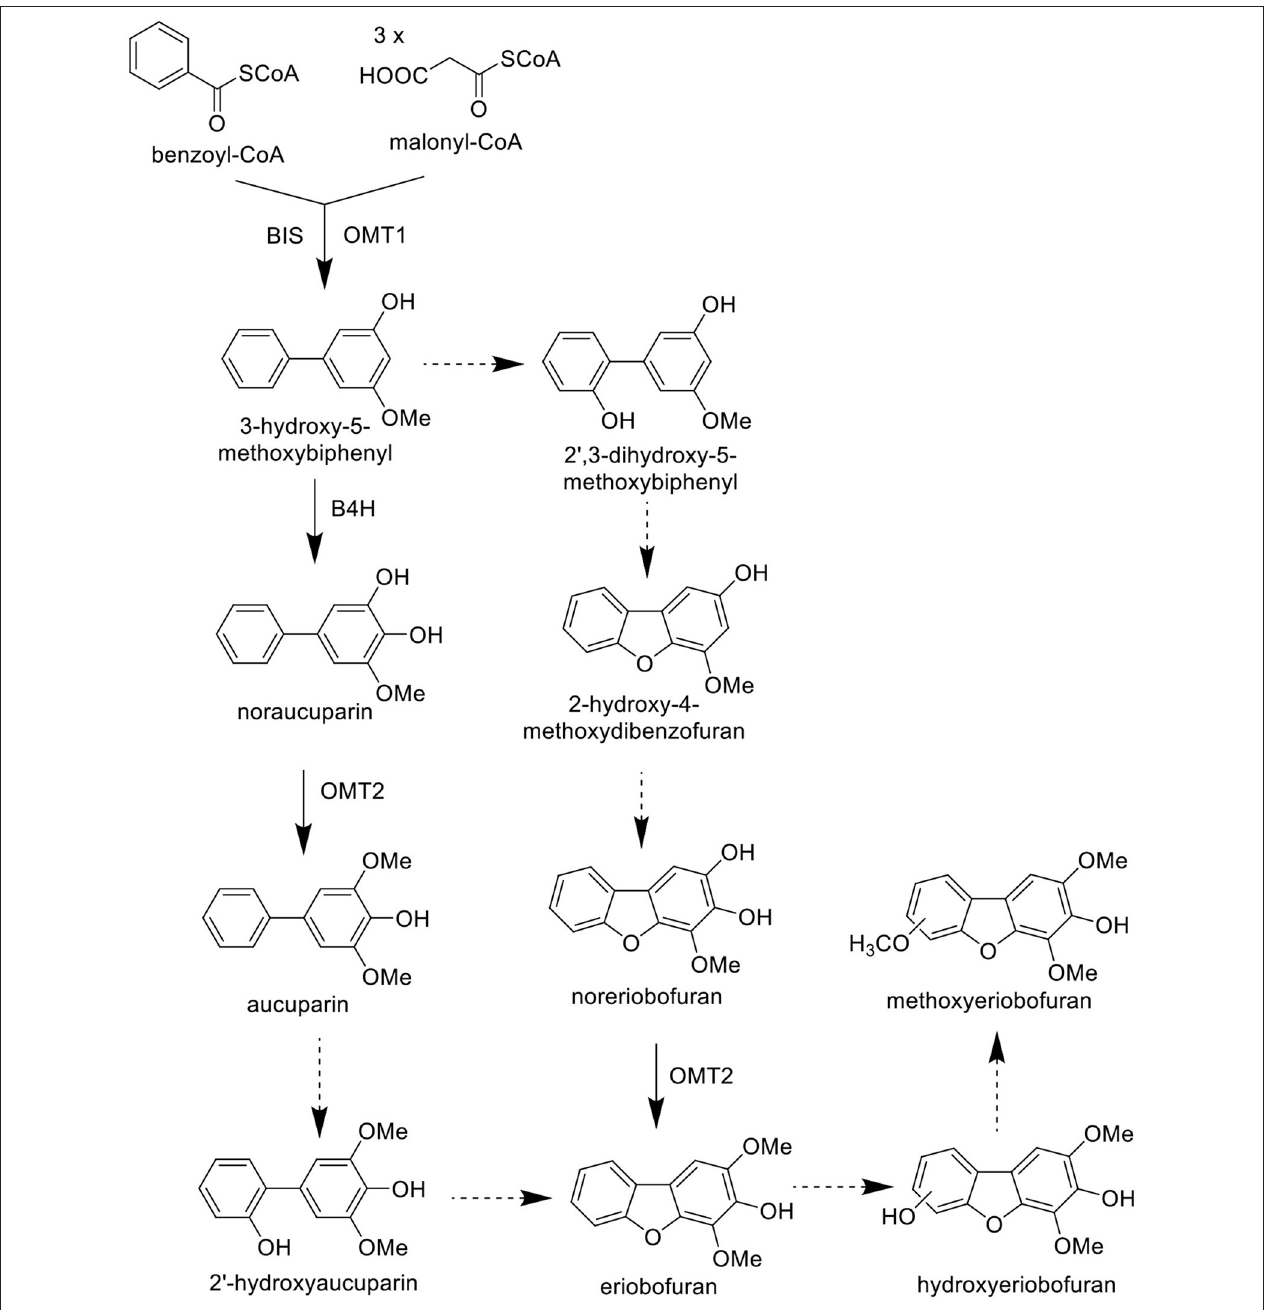
FIGURE S2 | Proposed biosynthetic pathway of biphenyl and dibenzofuran phytoalexins. Solid arrows represent established steps whereas broken arrows mark hypothetical reactions. BIS, biphenyl synthase; OMT, o -methyltransferase; B4H, biphenyl